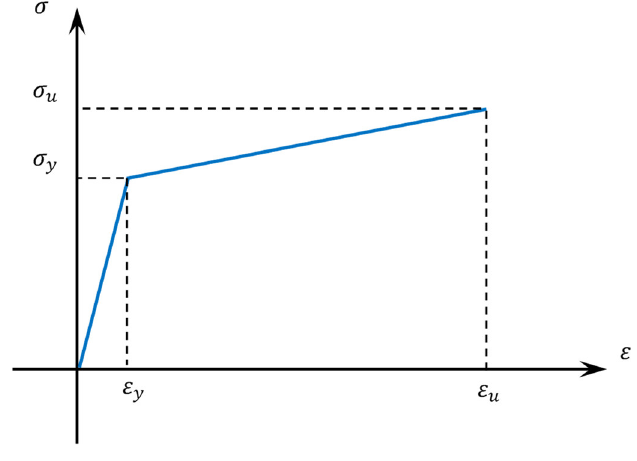
Figure 7. The idealized curve of σ - ε for reinforcing steel rebars. Table 4. Reinforcing steel rebar material characteristics [47]. Rebar Diameter (mm)